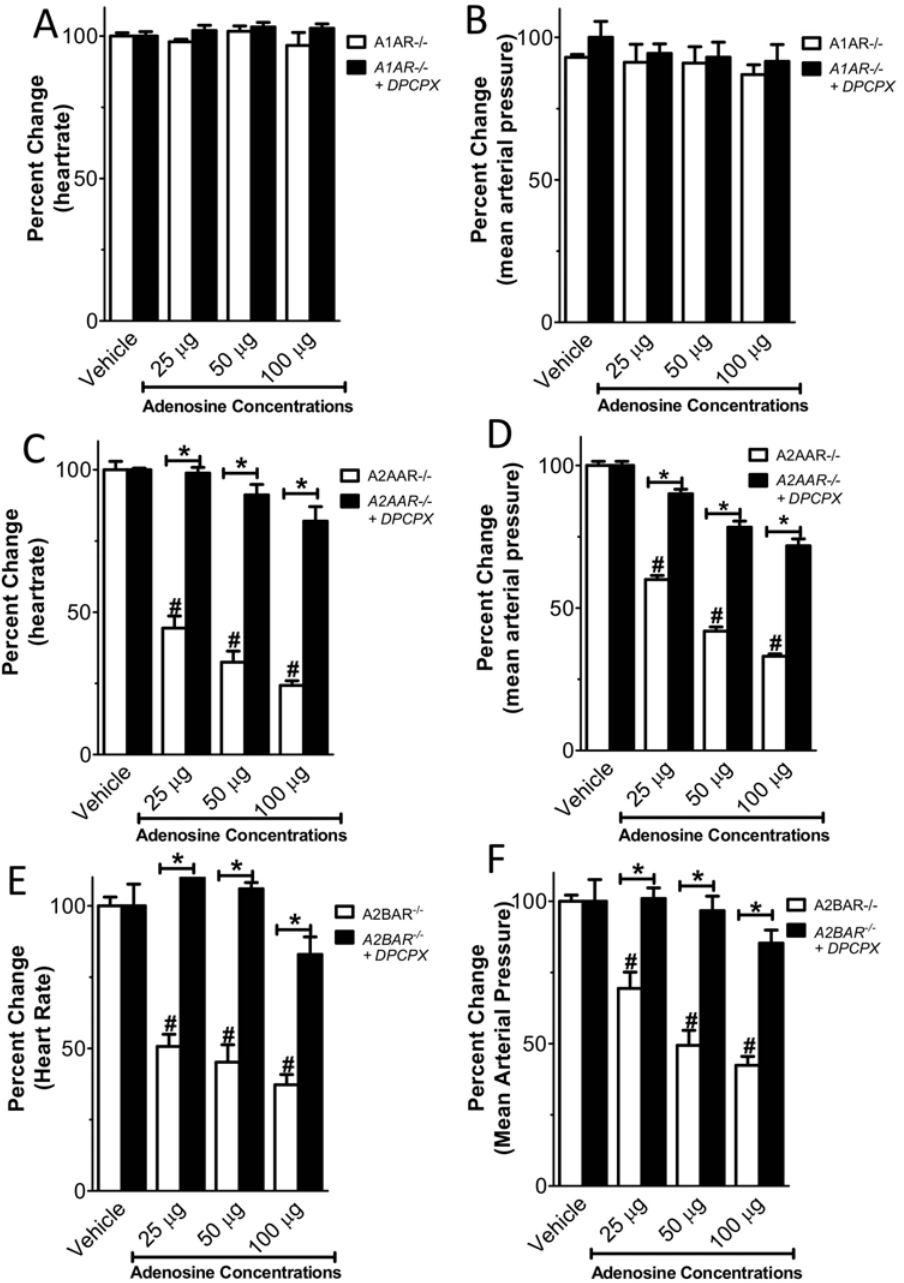
Figure 6. Effect of A1 adenosine receptor (AR) antagonist DPCPX in AR gene targeted mice. Following insertion of a catheter into the common carotid artery, mean arterial blood pressure and heart rate were measured after injection of vehicle or adenosine at indicated doses (volume of 100 m l). All animals received 1 mg/kg of the A1AR antagonist DPCPX (i.p., 30 min prior to the experimental procedure) or vehicle. Relative changes in HR and MAP are displayed. (A, B) A1AAR 2 / 2 (C, D) A2AAR 2 / 2 (E, F) A2BAR 2 / 2 (n=4;* p , 0.05 compared to DPCPX treated mice; # p , 0.05 compared to adenosine-vehicle; mean 6 SEM).